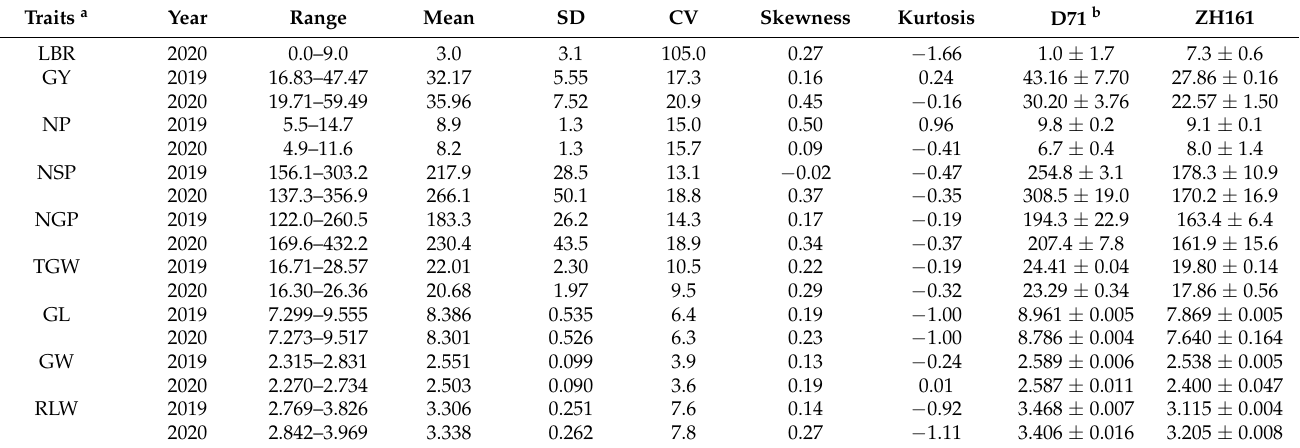
Table 1. Performance of leaf blast resistance and yield traits in the D71/ZH161 RIL